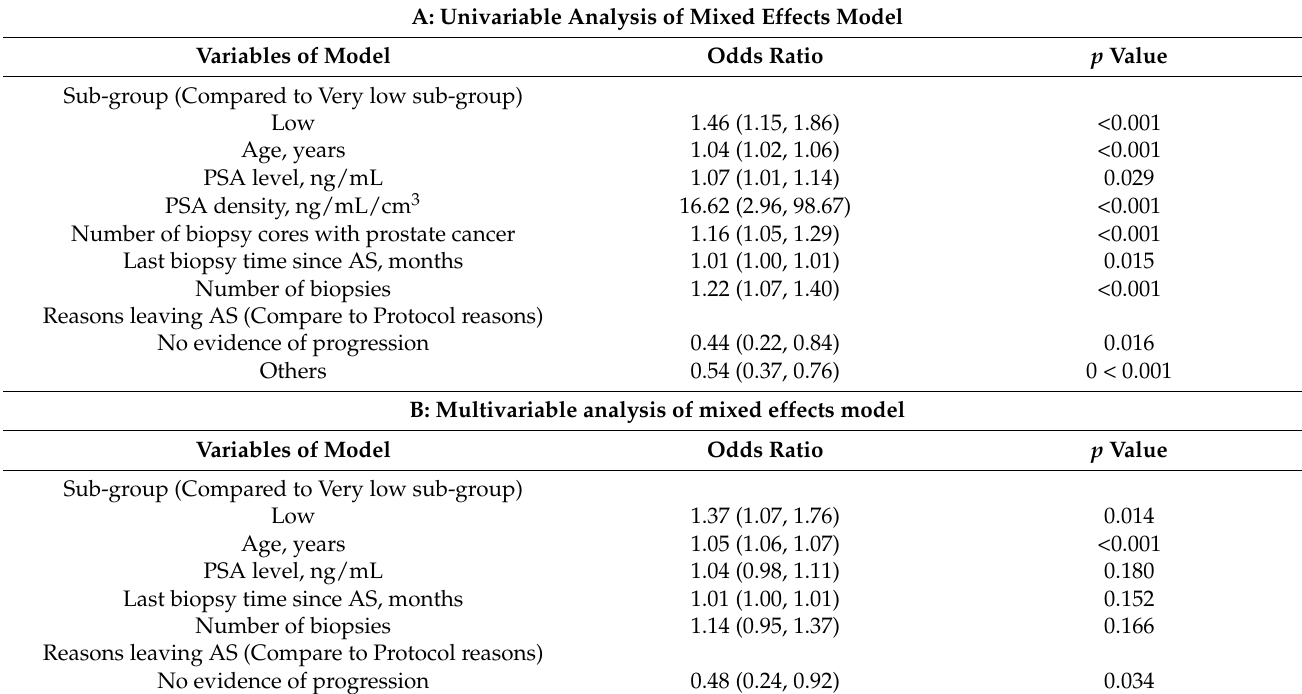
Table 3. Univariable (A) and multivariable (B,C) analyses for adverse pathological